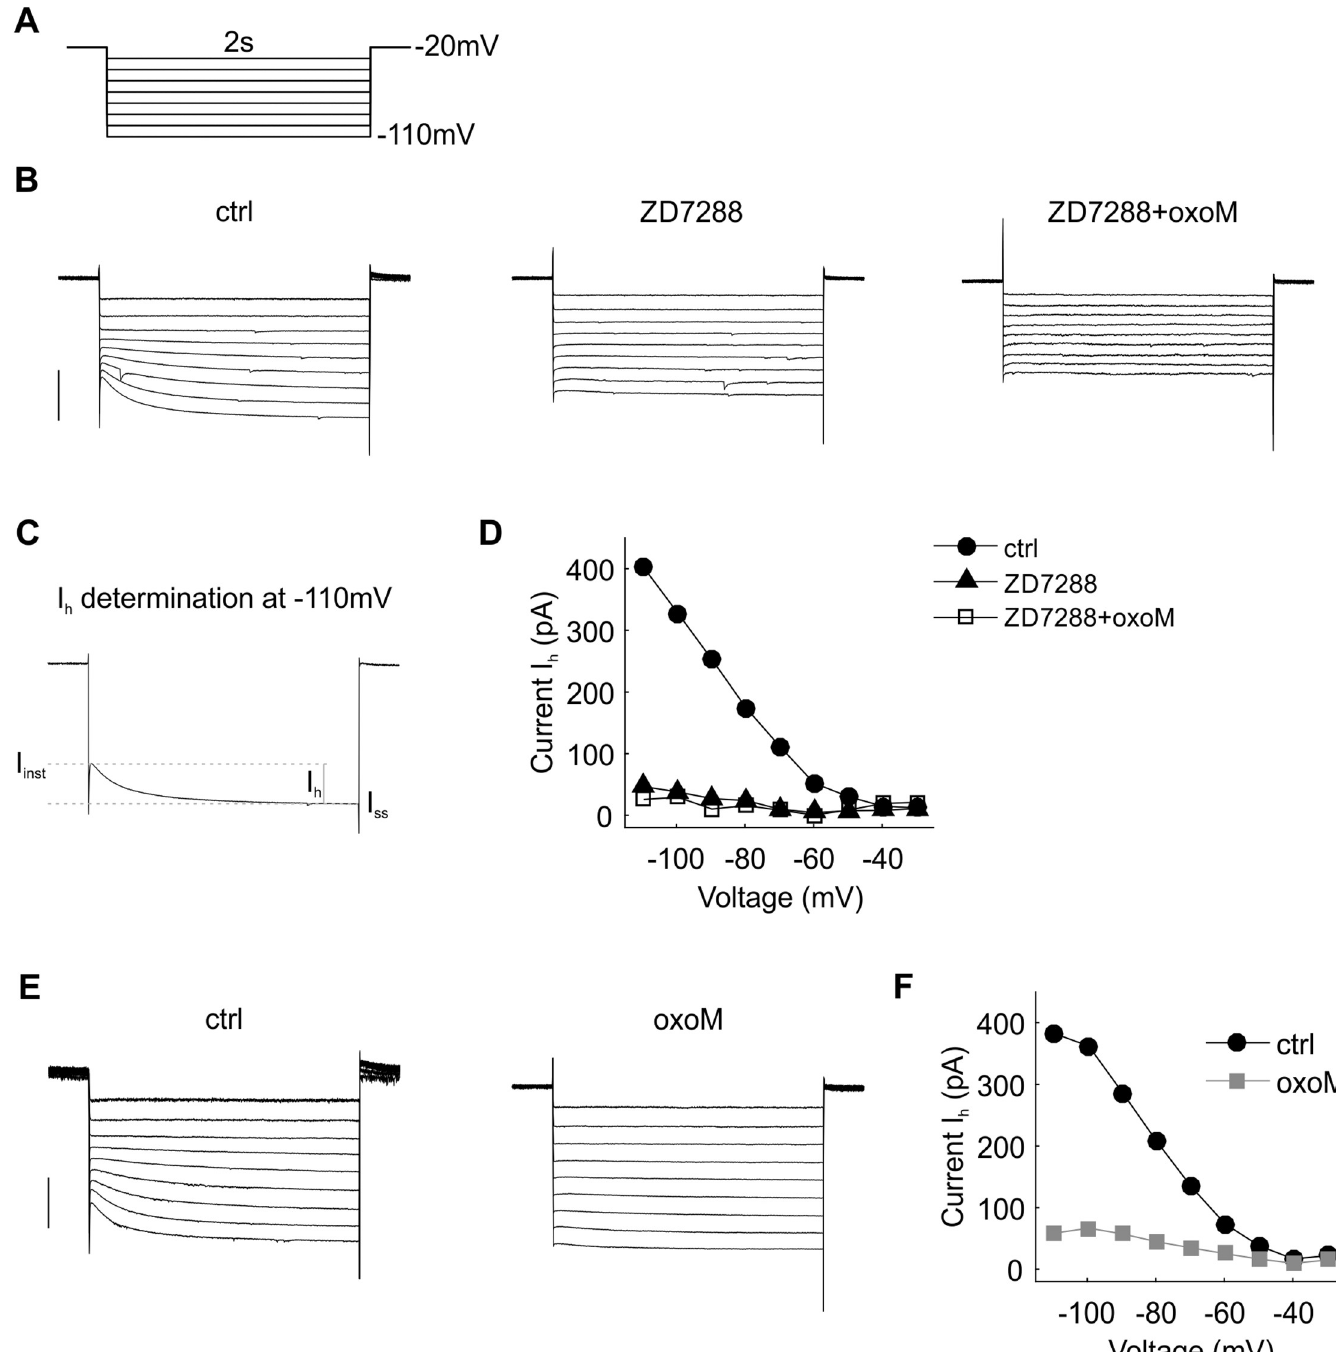
Fig 4. I h suppression by oxoM in an example cell. (A) Deactivation protocol with voltage steps (2 s) from -110 mV to -30 mV. (B) Example traces of current recordings in control (ctrl) condition (left part), after ZD7288 wash-in (middle part) and application of oxoM in presence of ZD7288 (right part); scale: 500 pA. (C) Step at -110 mV from B (left part) showing how the inward current I h was measured. I h was clearly visible at the more hyperpolarized voltage steps in ctrl but was almost completely gone in presence of ZD7288. (D) Values of I h at each voltage for the cell shown in B. (E) Example traces of current recordings in control condition (upper part) and after application of oxoM; scale: 500 pA. (F) Values of I h at each voltage for the cell shown in E. I h was also considerably reduced by the application of oxoM alone.